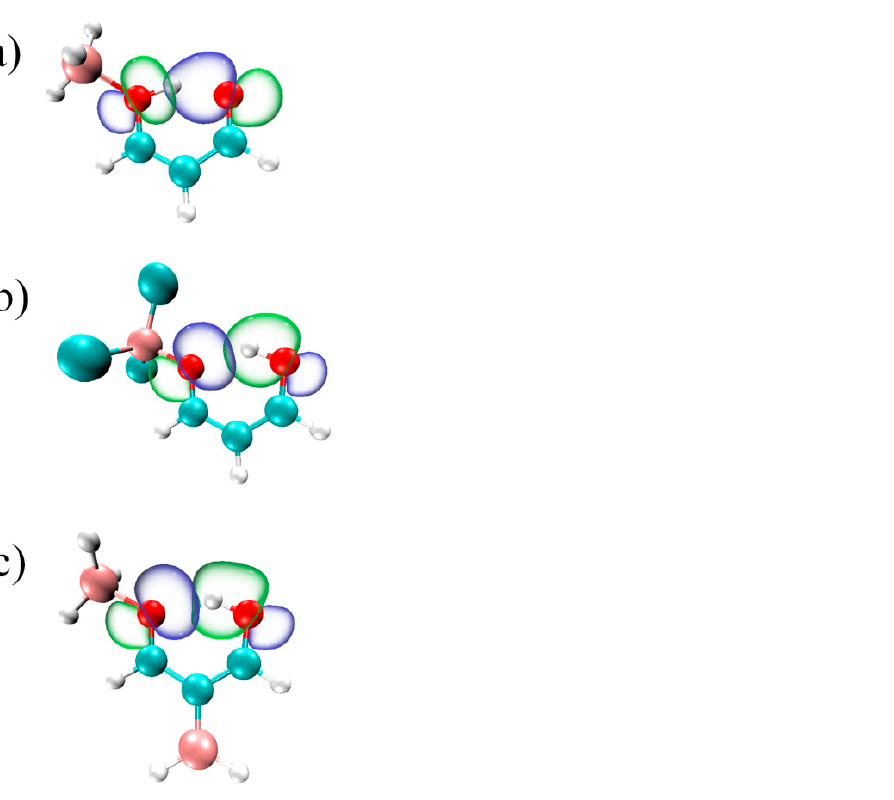
Figure 6. Diagrams of LpO → σ *H-O orbital interaction in ( a ) MDA-BH 3 -a, ( b ) MDA-BCl 3 -a, and ( c ) BH 2 -MDA-BH 3 -a.